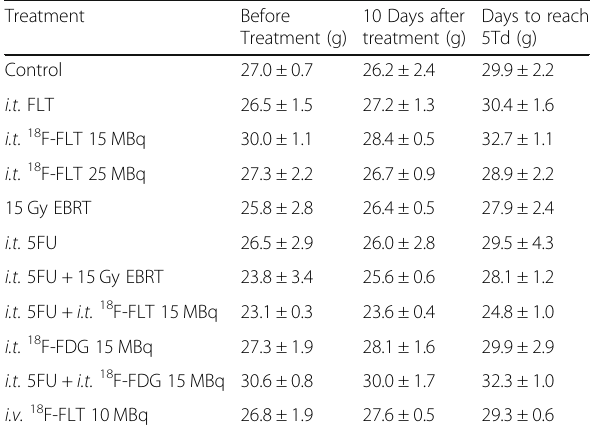
Fig. 8 Immunohistochemical staining showing Ki67-based proliferation measured after treatment with i.t. 18 F-FLT or 15 Gy EBRT, which were also combined with i.t. 5FU. ns: p > 0.05; * p ≤ 0.05; ** p ≤ 0.01; **** p ≤ 0.0001